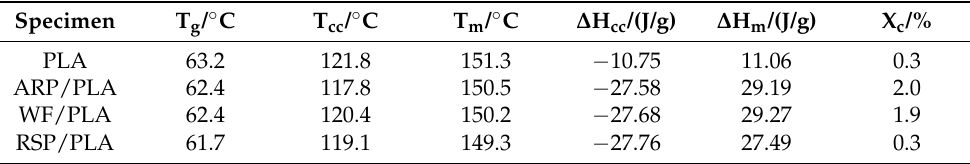
Figure 6. The secondary heating curves of different samples. Table 2. DSC thermal information of different